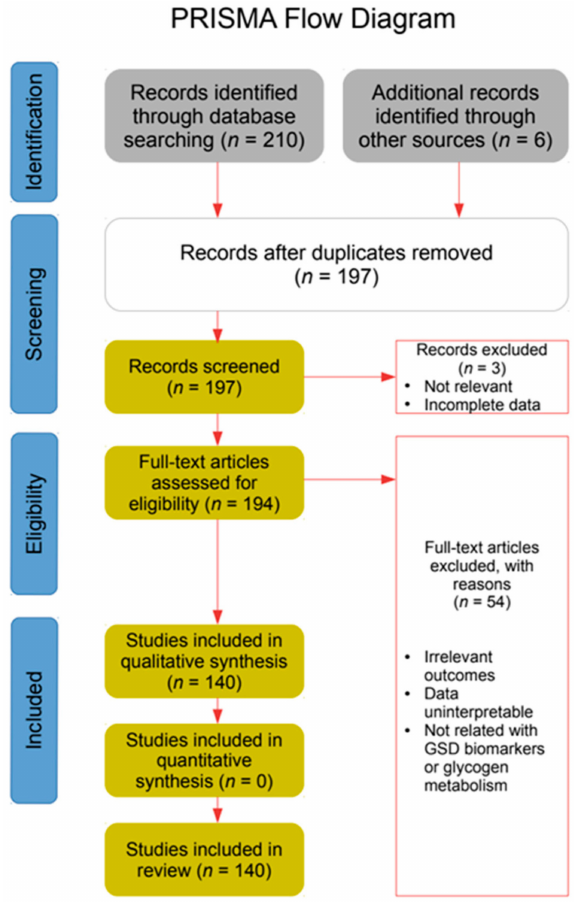
Figure 2. PRISMA flow diagram of bibliographic